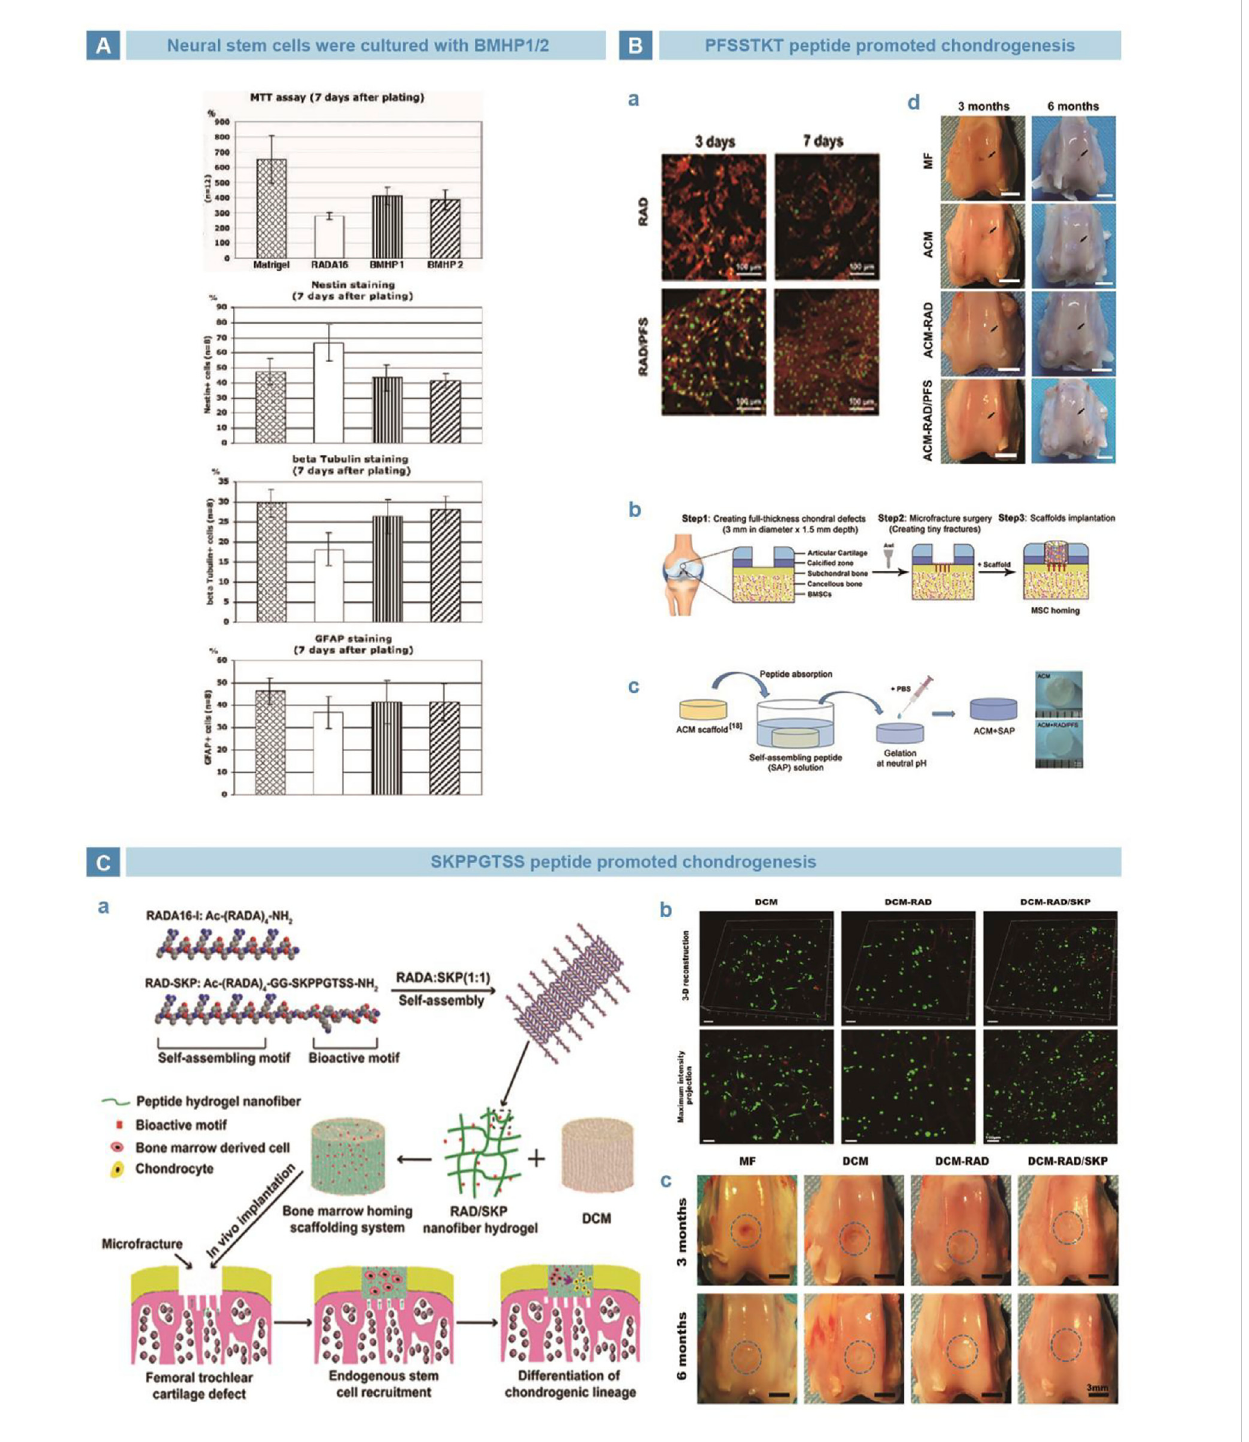
FIGURE 3 BMHP-mimetic peptides, PFSSTKT and SKPPGTSS in tissue engineering. (A) . BMHP1 (PFSSTKT) and BMHP2 (SKPPGTSS) recruited NSCs to local tissue, and the cell behaviors were stable, compared with Matrixgel (Gelain et al., 2006). (B) . PFSSTKT in cartilage tissue engineering. RAD/PFS hydrogel did favor to theadhesionofrabbitBMSCs (A) .RAD/PFSwasmergedinacellularizedcartilagematrixscaffoldtoacquirefunctionalcompositescaffold,thenimplantedinto full-depthrabbitkneecartilagedefect (B) .PFSSTKTwasconjugatedwithpeptideRADA-16Itopreparefunctionalself-assemblingpeptidehydrogelRAD/ PFS (C) .BetterreconstructionofarticularcartilagewasfoundafterimplantingRAD/PFS/ACMcompositescaffoldintorabbitkneecartilagedefect (D) (Luetal., 2018). (C) . SKPPGTSS in cartilage tissue engineering. Conjugation of RAD and SKPPGTSS, and fabrication of composite scaffold of RAD/SKP/DCM (A) . BMSCs stayed healthy on different scaffolds (B) . RAD/SKP/PFS group showed ideal neocartilage at rabbit knee cartilage defect area (C) (Sun et al.,